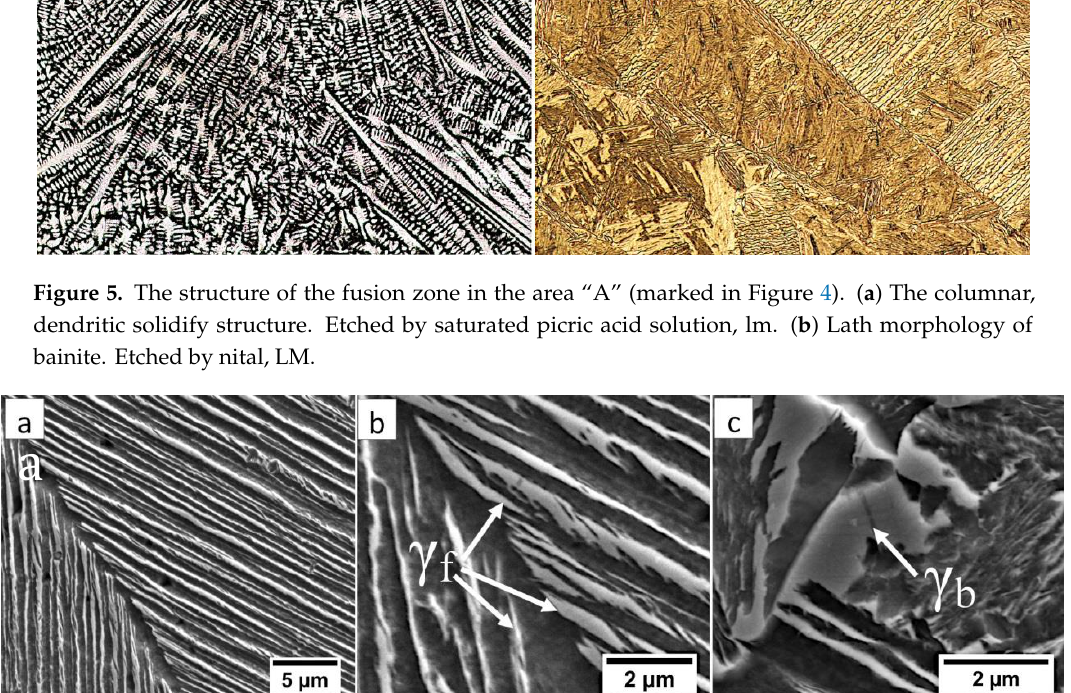
Figure 6. The structure of the fusion zone in the area “A” (marked in Figure 4). ( a ) Lath morphology of coarse bainite inside dendrites. ( b ) Magnification of the area is presented in Figure 6a. Lath morphology of bainitic ferrite and filmy austenite (γ f ). ( c ) Area of blocky retained austenite (γ b ). Etched by nital, SEM.